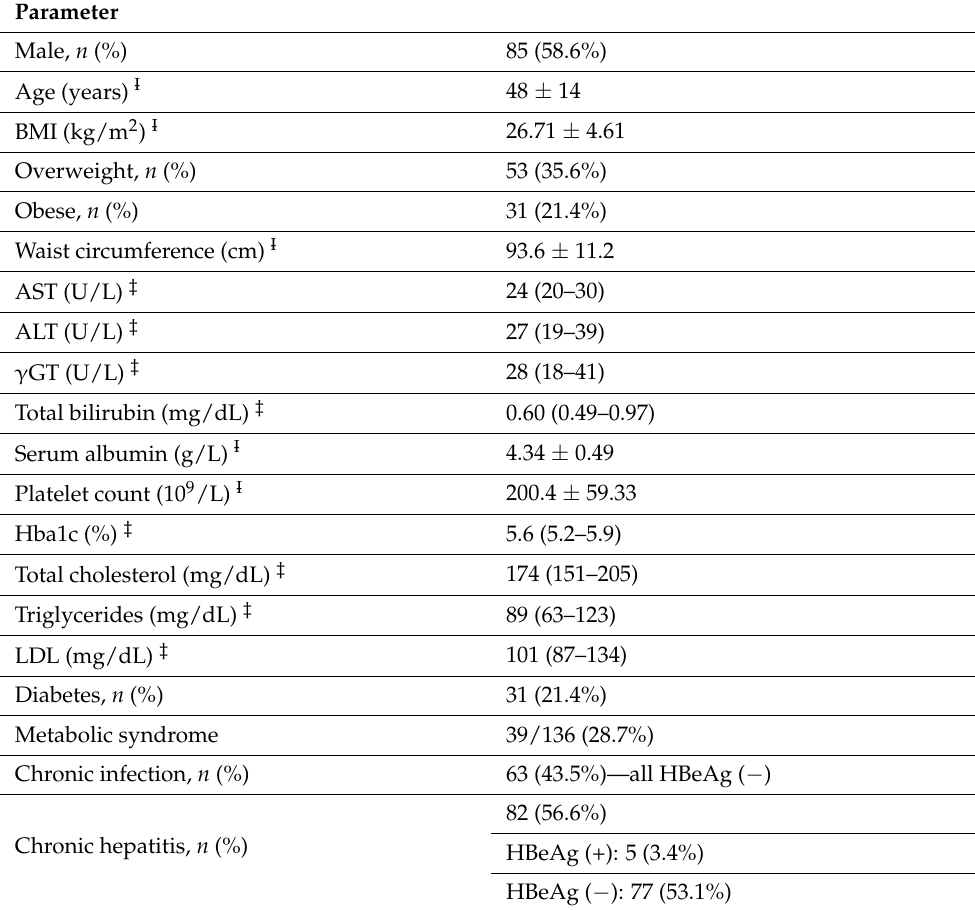
Table 1. Demographic, serological and laboratorial data for patients with chronic hepatitis B ( n = 145).